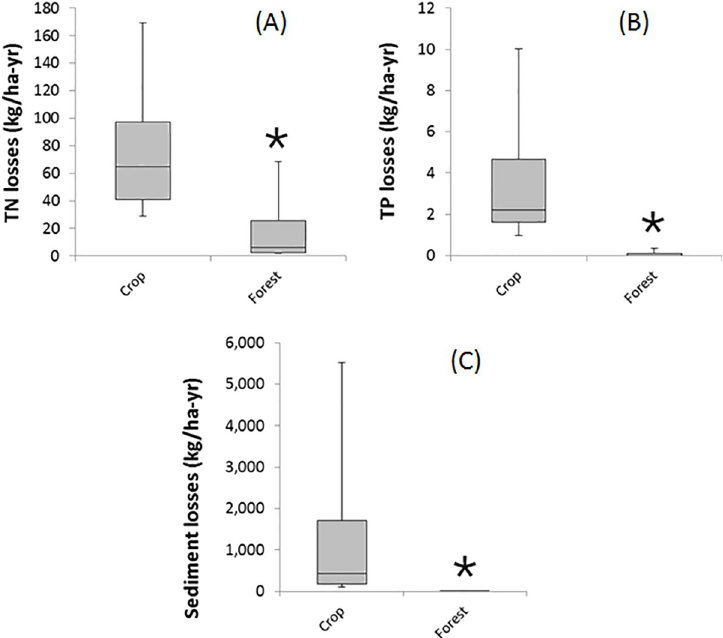
Fig 5. Export of (A) TN, (B) TP, (C) sediments from corn fields (crop) compared to the same field used for forest, for n = 1,653 fields in the northern Ohio River Basin. Differences are statistically significant (p <